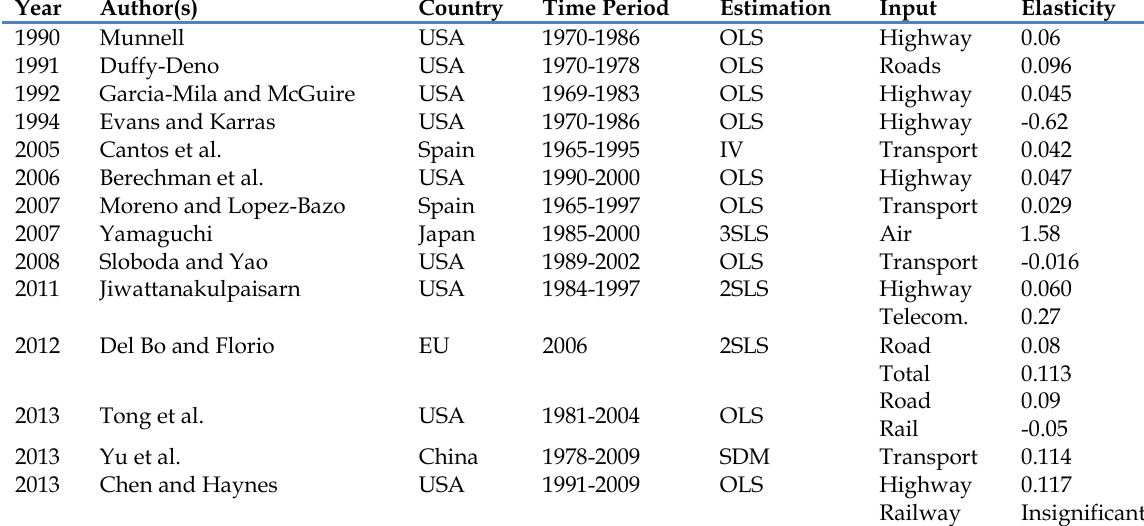
Table 1. Various empirical studies that employ the Cobb–Douglas production